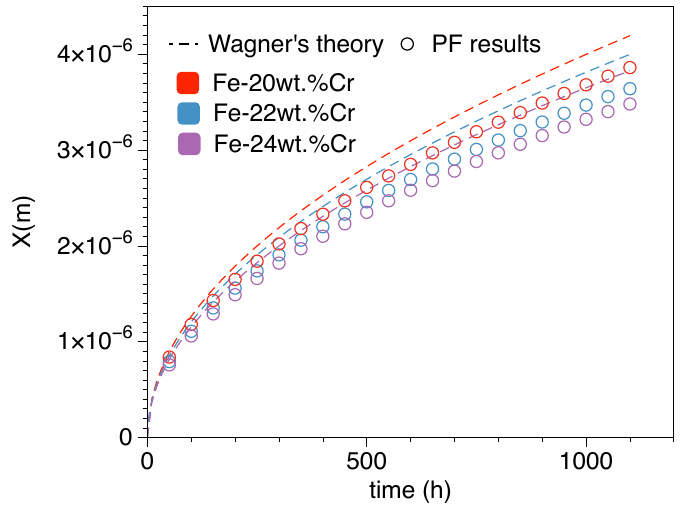
Figure 3. Comparison of the oxide scale thickness X of the Cr 2 O 3 layer obtained from PF results and the predictions of Wagner’s theory for different Cr concentrations in the matrix phase with = 0.22 at T = 1073 K. The PF results predict similar trends as Wagner’s N 0 Cr